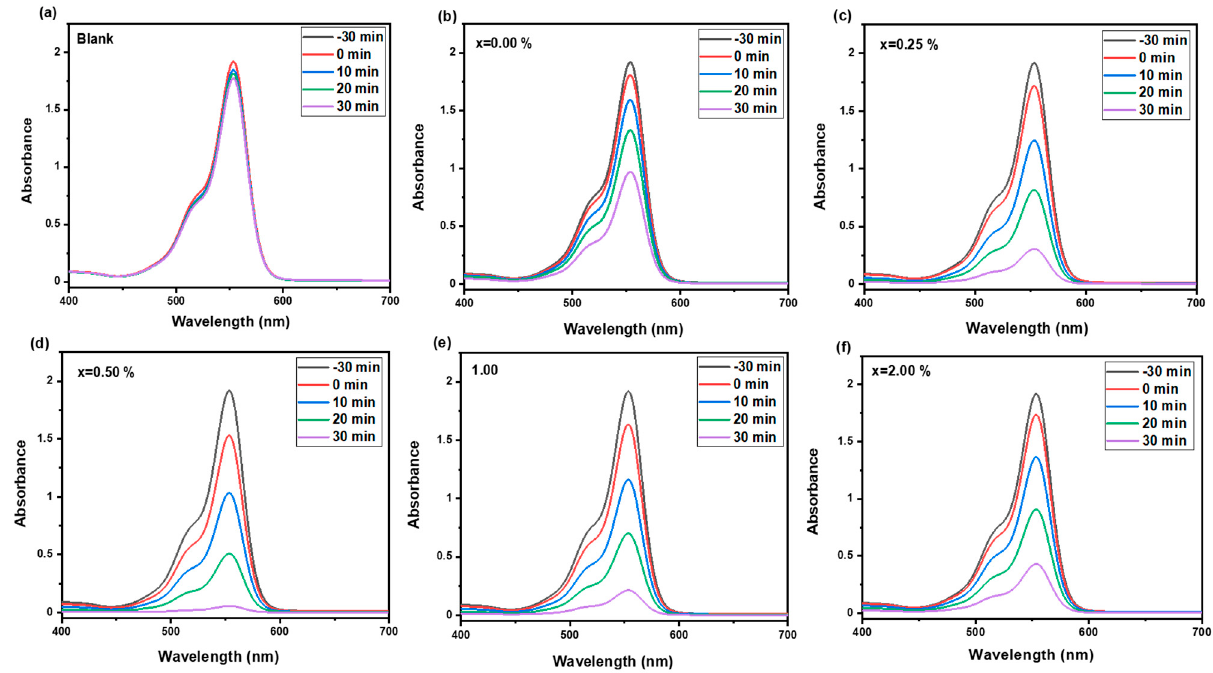
Figure 9. Photocatalytic degradation of RB dyes of Ce–Sm co-doped TiO 2 NPs (( a ) blank ( b ) x = 0.00%, ( c ) x = 0.25%, ( d ) x = 0.50%, ( e ) x = 1.00%, and ( f ) x = 2.00%).